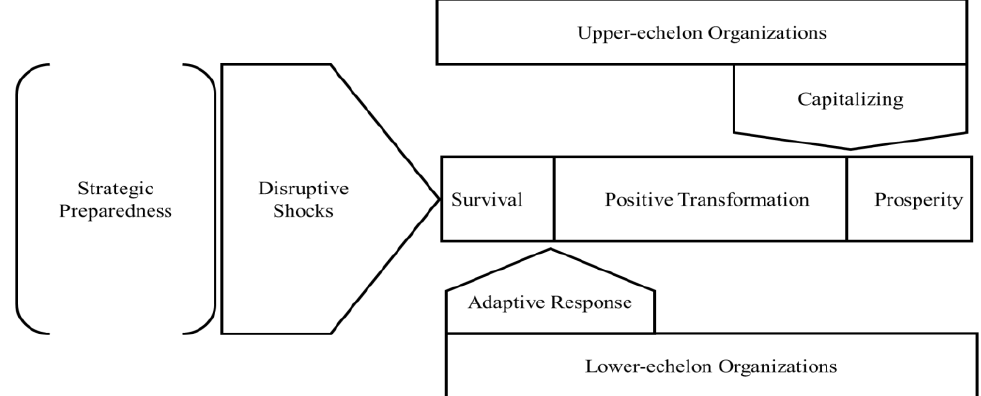
Figure 3: Strategy-induced Organisational Spheric Clustering; Source: Ahmed et al. (2021c, p.